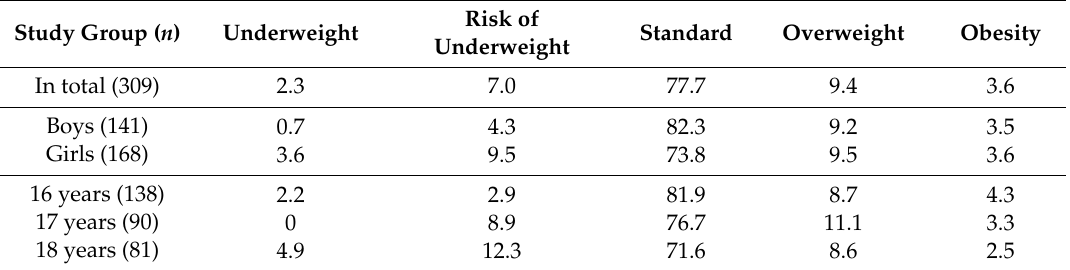
Table 2. Body mass index (BMI) interpretation with reference to gender and age [%].